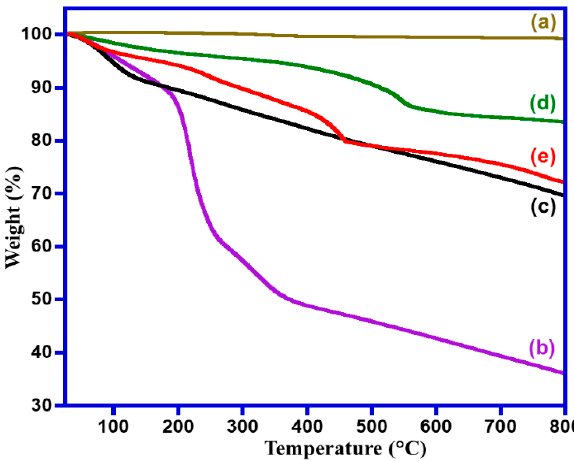
Figure 2. TGA curves of ( a ) graphite, ( b ) GRO, ( c ) NDG, ( d ) MnCO 3 –(1%)ZrO 2 and ( e ) (1%)NDG/MnCO 3 –(1%)ZrO 2 nanocomposites. FTIR spectra of GRO, NDG, and (1%)NDG/MnCO 3 –(1%)ZrO 2 samples are plotted in Figure 3. In